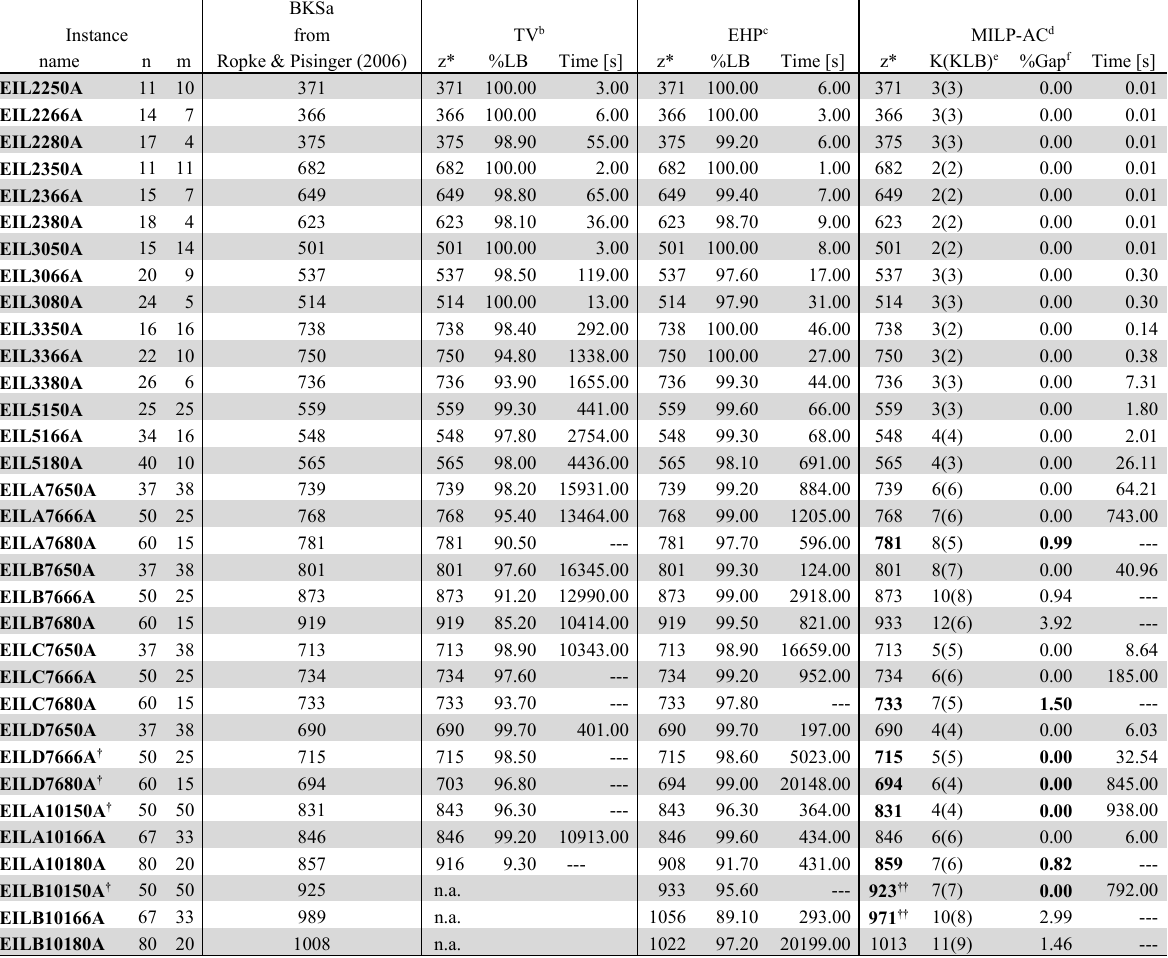
Computational results for the VRPB cases from Toth & Vigo (1997) BKSa Instance from